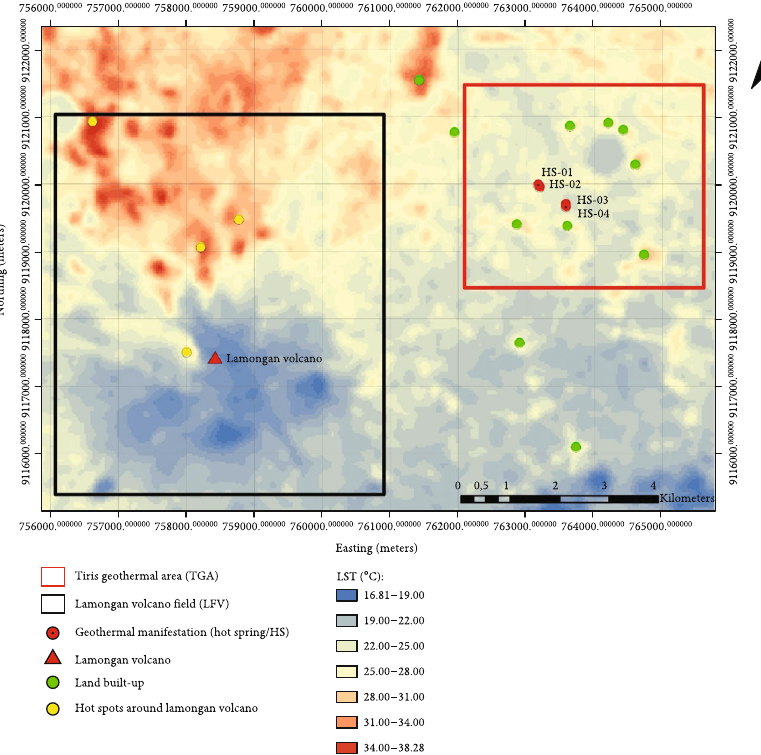
Figure 4: Estimation of ESG results from satellite coverage for the Tiris geothermal area of the Lamongan Volcano